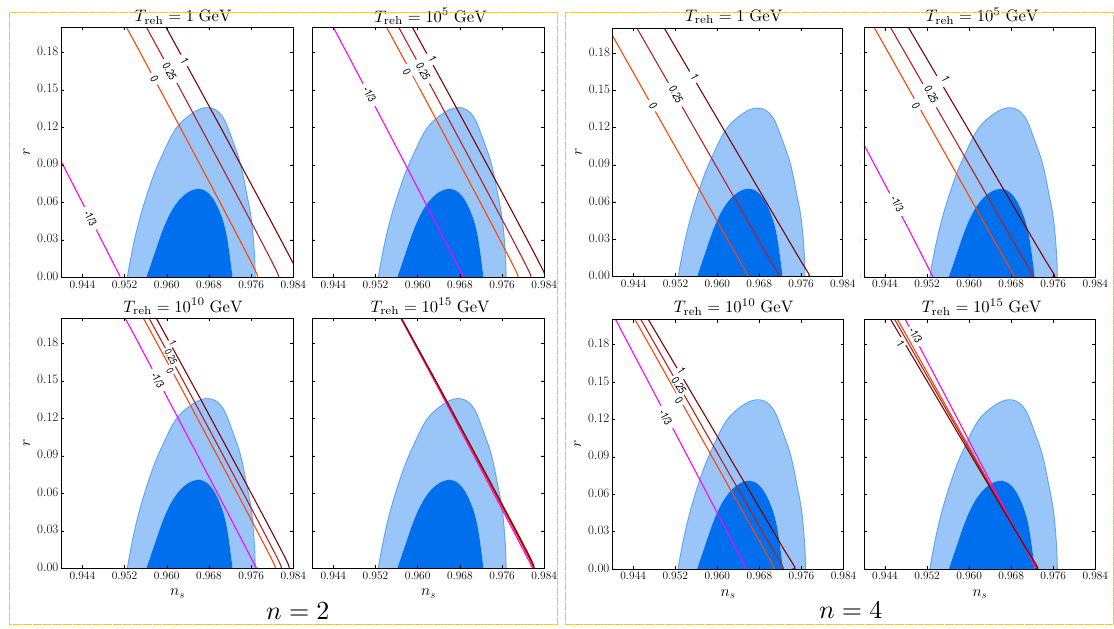
Figure 2. Predictions in the n s - r plane for the Generalised Gaussian Model (17) with n = 2 (left block of four panels) and n = 4. Each block contains four panels for reheating temperatures T reh = 1 − 10 15 GeV. In each panel, the lines show predictions for the reheating equation of state ¯ w = − 1/3,0,0.25 and 1. On each line, as the model parameter α is varied from small to large, r decreases steadily towards zero. See Section 5.1 for